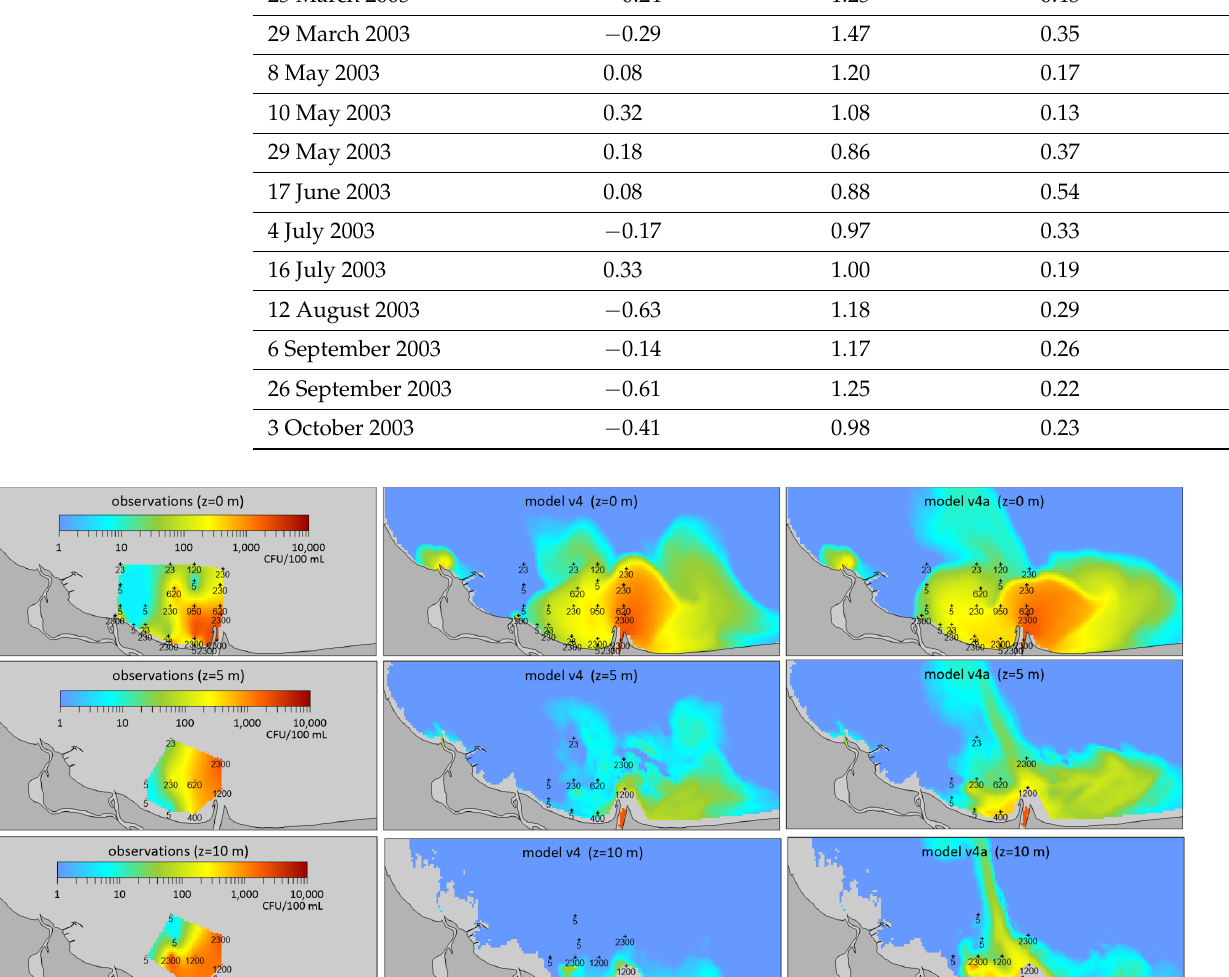
Figure 2. Distribution of E. coli concentration in the study area on 12 August 2003 at the depths of 0, 5, and 10 m; left : observed distributions; center : reference version of the model (v4); right : results of simulation modeled with assumed high concentration of E. coli in water flowing through the collector (v4a). Points indicate the location of the station and measured values. The standard version of model calculations (v4) presented high concentrations in the foreland of the Vistula mouth only in the surface layer. However, measurements showed high concentrations of E. coli (up to 2300 CFU 100 mL − 1 ) also at depths of 5 and 10 m. As fresh water in the Vistula spreads in a thin surface layer, it cannot be the source of high bacteria concentrations at these depths. The probable cause of such bacteria content may be the inflow of water from the WWTP via the collector. Measurements of E. coli concen- trations performed on 12 August 2003 in wastewater discharged from the collector showed a concentration of 23,000 CFU 100 mL − 1 , and this value was used for model calcu- lations. However, regarding these concentrations, only slightly higher values in the v4 model results were observed in the close vicinity of the collector outlet. It was hypothe- sized that bacterial content was significantly higher on the days before the study and